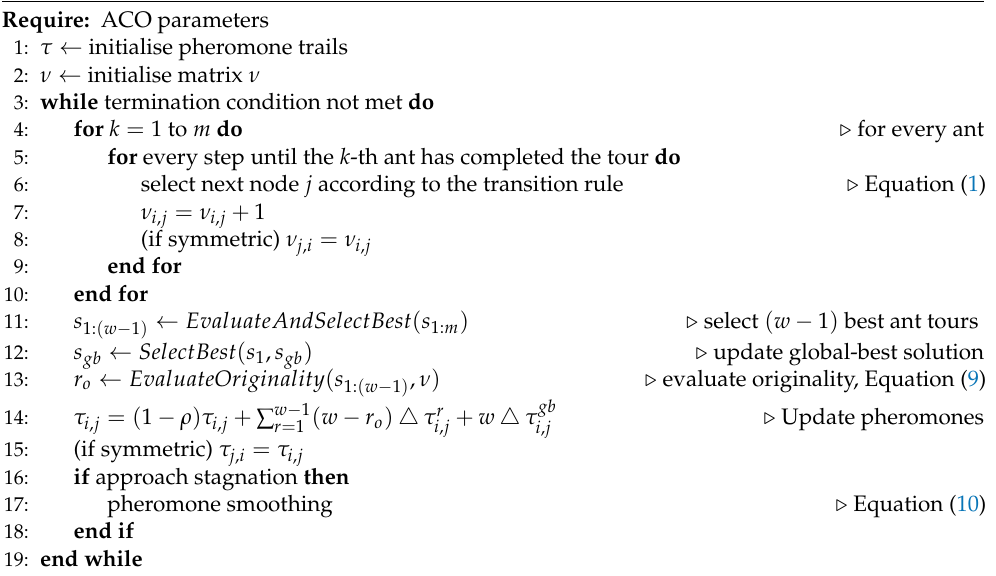
Algorithm 2 AS Rank with originality reinforcement and pheromone